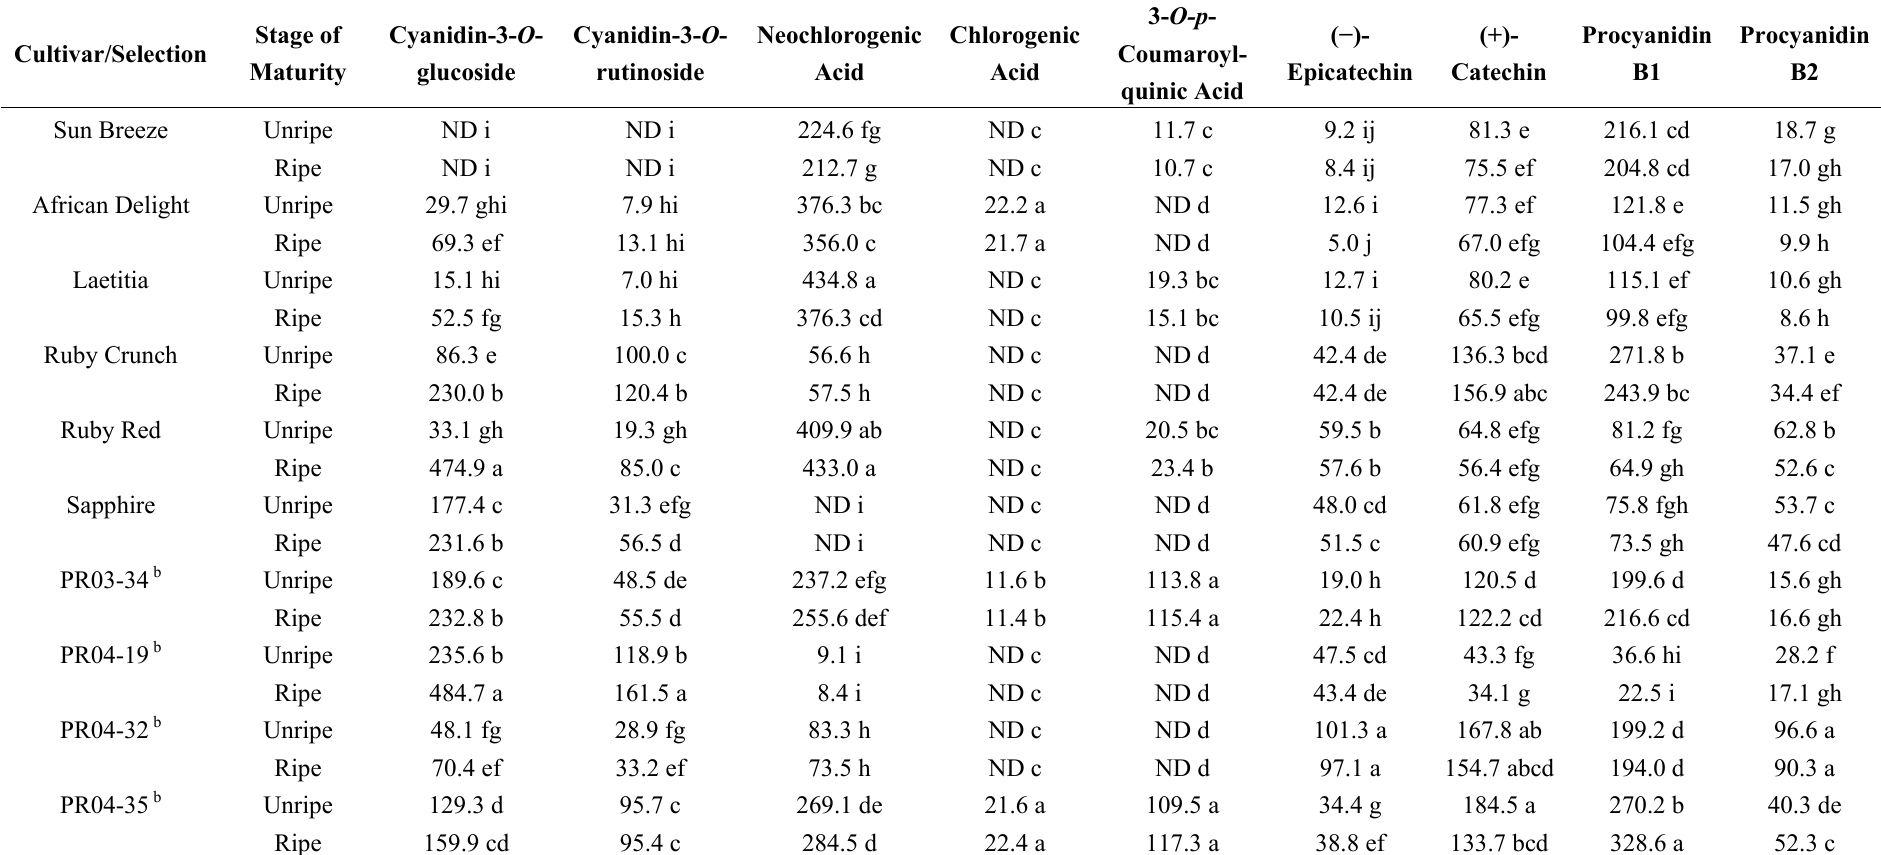
Table 5. Individual phenolic compound content (mg/kg fresh weight) of unripe and ripe fruits from South African plum ( Prunus salicina Lindl.) cultivars and selections of the second harvest season a